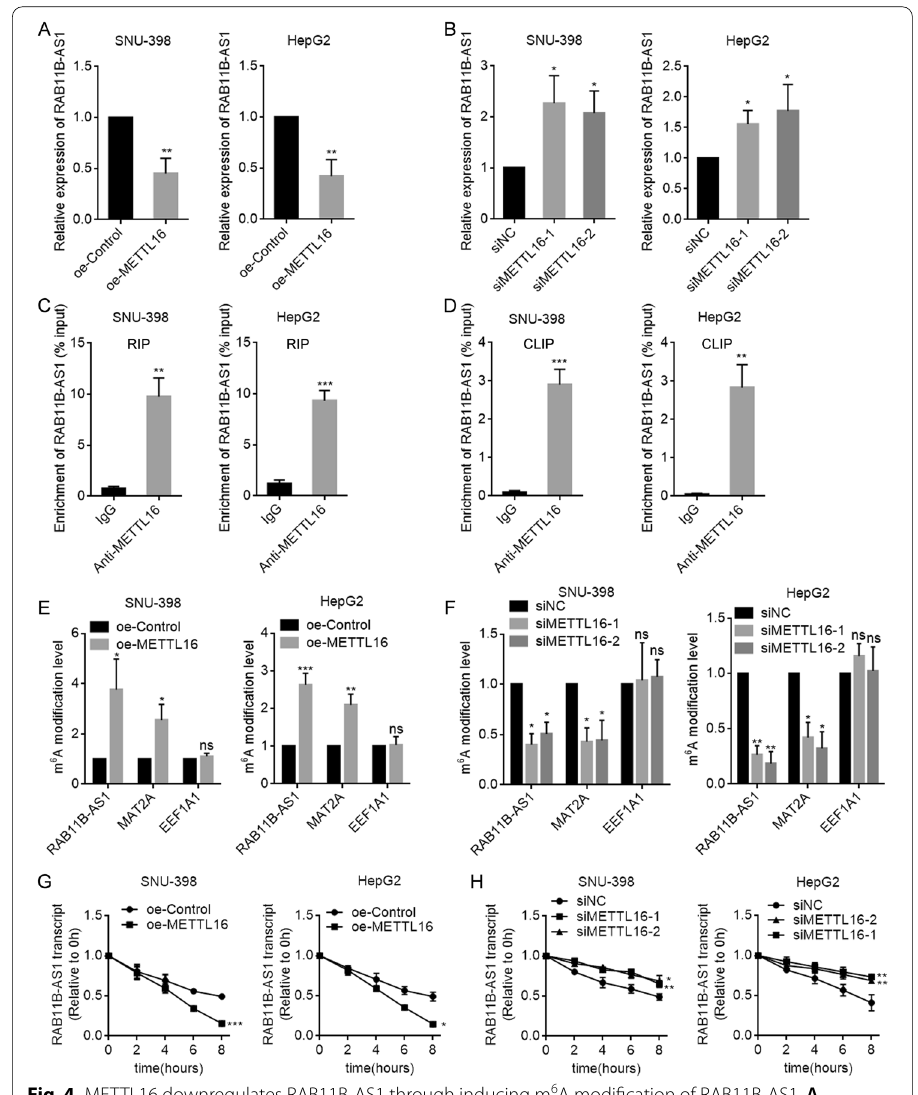
Fig. 4 METTL16 downregulates RAB11B‑AS1 through inducing m 6 A modification of RAB11B‑AS1. A RAB11B‑AS1 expression in SNU‑398 and HepG2 cells with METTL16 overexpression or control was detected by RT‑qPCR. B RAB11B‑AS1 expression in SNU‑398 and HepG2 cells with METTL16 knockdown or control was detected by RT‑qPCR. C RIP assays were performed in SNU‑398 and HepG2 cells to enrich the RNA bound by METTL16, followed by RT‑qPCR to detect the enrichment of RAB11B‑AS1. D CLIP assays were performed in SNU‑398 and HepG2 cells to enrich the RNA directly bound by METTL16, followed by RT‑qPCR to detect the enrichment of RAB11B‑AS1. E MeRIP assays were performed in SNU‑398 and HepG2 cells with METTL16 overexpression or control to enrich m 6 A modified RNA, followed by RT‑qPCR to assess m 6 A modification level of RAB11B‑AS1, MAT2A, and EEF1A1. F MeRIP assays were performed in SNU‑398 and HepG2 cells with METTL16 knockdown or control to enrich m 6 A modified RNA, followed by RT‑qPCR to assess m 6 A modification level of RAB11B‑AS1, MAT2A, and EEF1A1. G The stability of RAB11B‑AS1 over time was measured after blocking new RNA synthesis with α‑amanitin (50 µM) in SNU‑398 and HepG2 cells with METTL16 overexpression or control. H The stability of RAB11B‑AS1 over time was measured after blocking new RNA synthesis with α‑amanitin (50 µM) in SNU‑398 and HepG2 cells with METTL16 knockdown or control. Results are shown as mean SD of n 3 independent experiments. * P < 0.05, ** P < 0.01, *** P < 0.001 ± = by Student’s t ‑test ( A , C , D , E , G ) or one‑way ANOVA followed by Dunnett’s multiple comparisons test ( B , F , H